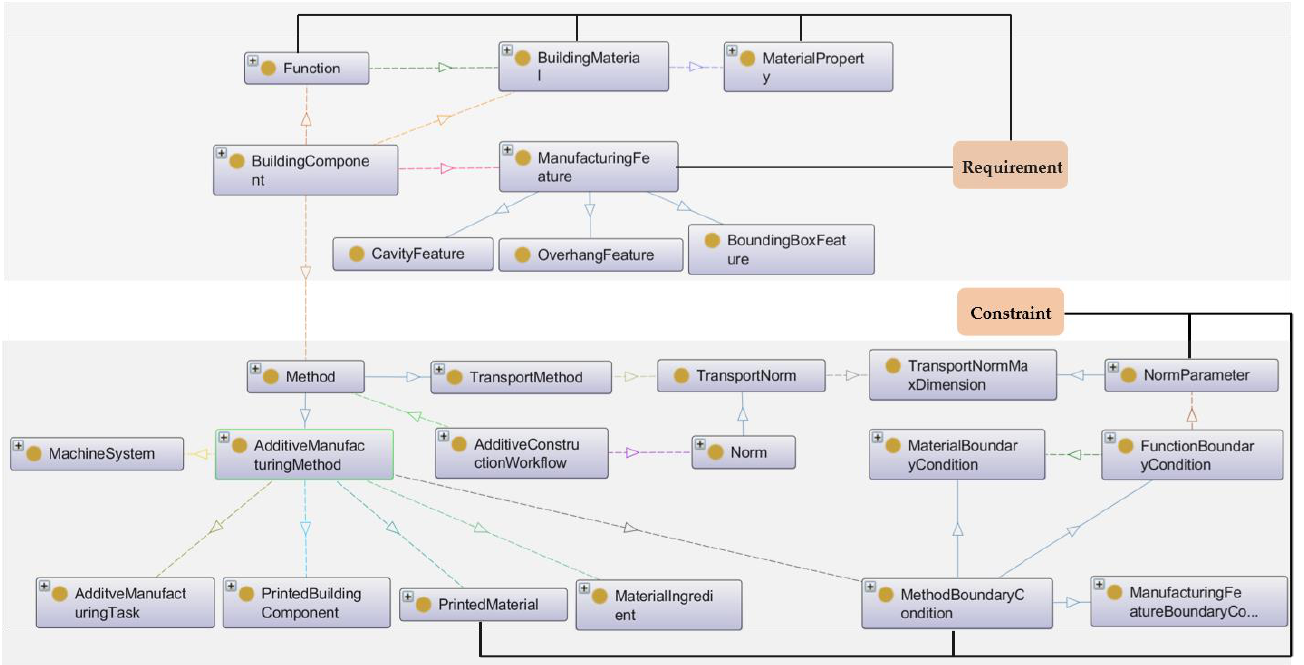
Figure 7. Excerpt of formalized AMC ontology. The black solid line segments recognize relevant terms as requirements and constraints.